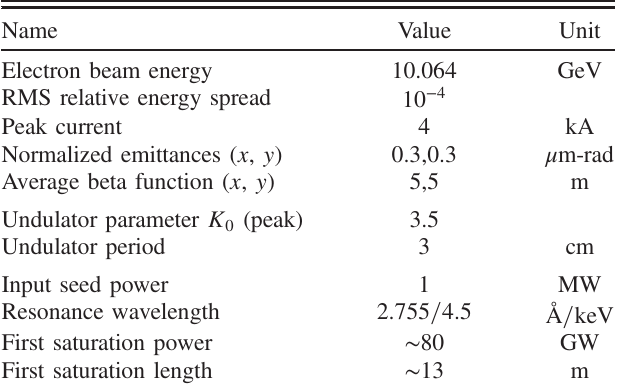
TABLE I. Numerical parameters for the beam, undulator and radiation fields for the hard x-ray